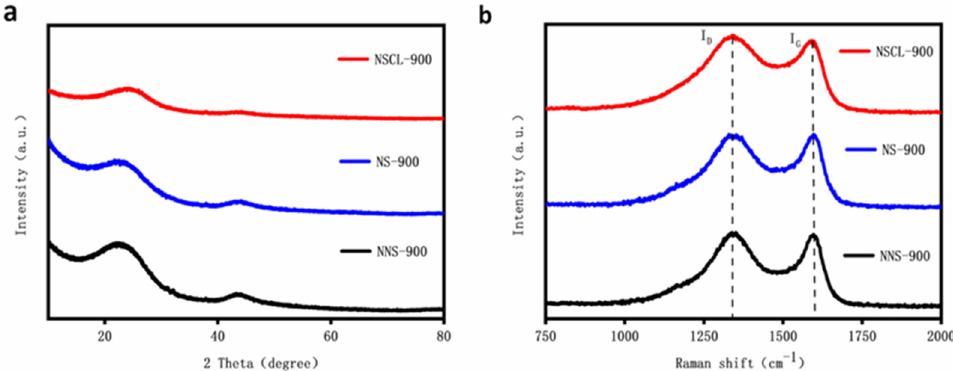
Figure 2. XRD patterns ( a ) and Raman Spectra ( b ) of NSCL-900, NS-900, and NNS-900. Raman spectroscopy effectively revealed the defect levels and graphitization degrees of NSCL-900, NS-900, and NNS-900 [37]. As shown in Figure 2b, peaks D and G can be observed at 1350 cm − 1 and 1590 cm − 1 . Peak D is generally regarded as the disordered vibration peak of graphene, which is used to characterize the defects of carbon-based catalysts [38]. Peak G is the main characteristic peak of graphene, reflecting the number of layers of graphene. I D / I G is an important index of the defect level and graphitization degree of a catalyst [39]. According to spectral calculation, the I D / I G values of NSCL-900, NS-900, and NNS-900 are 1.05, 0.93, and 0.86, respectively, indicating that the introduction of urea will cause the disorder of the carbon structure and that the urea treatment will increase the defect level of the carbon structure [40].